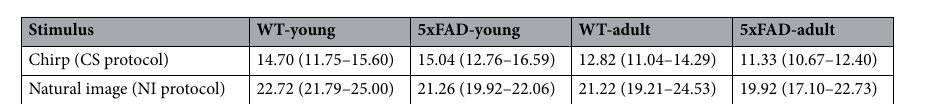
Table 1. Complexity index for the four groups in response to two stimuli. ✝ Median (lower–upper quartile).